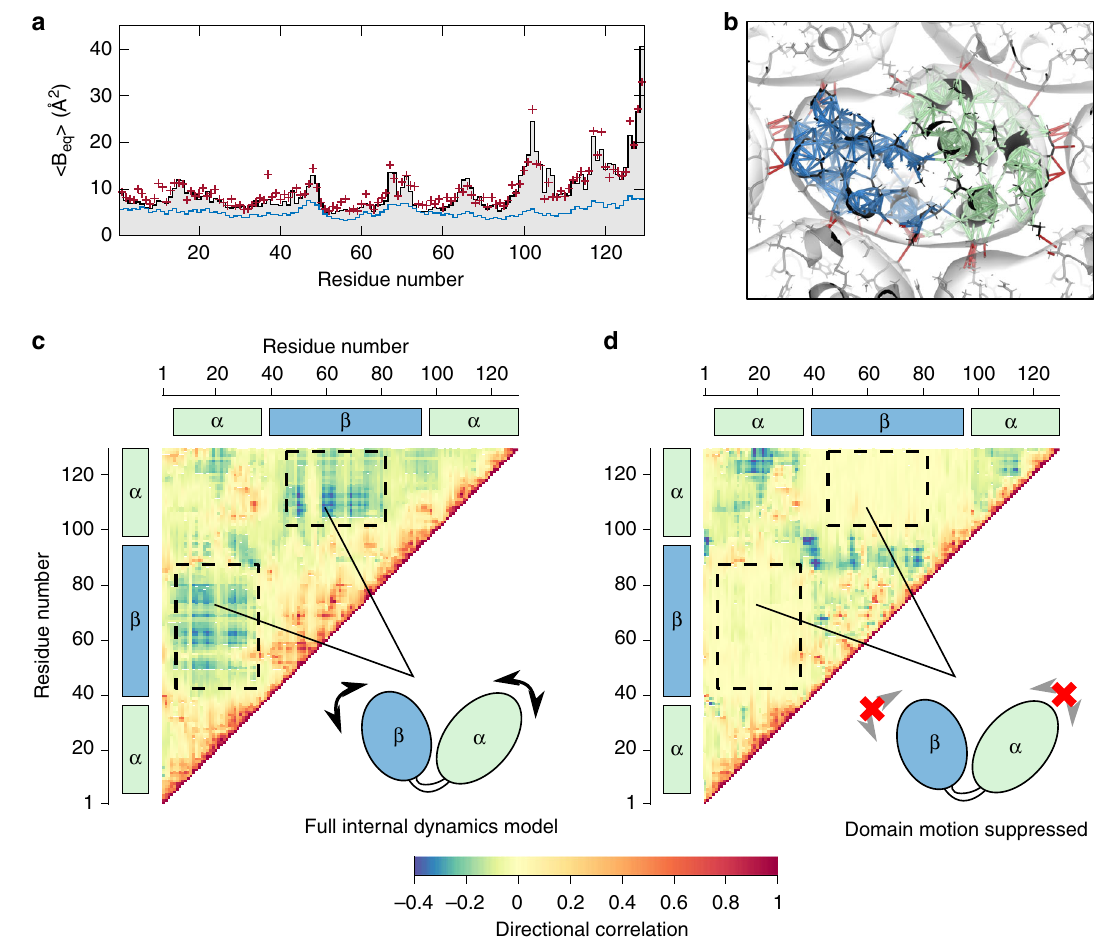
Fig. 4 Models of collective internal motions in lysozyme re fi ned to Bragg data. a Apparent atomic motions can be evaluated by comparing the atomic displacement parameters (ADPs) obtained experimentally from Bragg data with those calculated from models. To facilitate visual comparison, the ADPs of backbone atoms are averaged to produce a single isotropic B-factor per residue. The lattice dynamics model in Fig. 3 (blue curve) underestimates the experimental B-factors (gray bars), but a good fi t is obtained by combining lattice dynamics with the internal dynamics described in ( b , c ) (dark red symbols). b The model for internal dynamics was constructed using an elastic network with rigid residues. Both intermolecular (dark red lines) and intramolecular contacts (blue and green lines, corresponding to the α and β domains, respectively) were modeled as springs, and the spring constants were re fi ned to fi t the residual ADPs, i.e. the experimental ADPs that are unaccounted for by lattice dynamics. c In the full internal dynamics model, the C α atoms in the α and β domains show negative directional correlations (dashed boxes), indicating that their motions are anti-correlated and consistent with hinge- bending. d The two domains have no correlations when their motions are suppressed in the model re fi